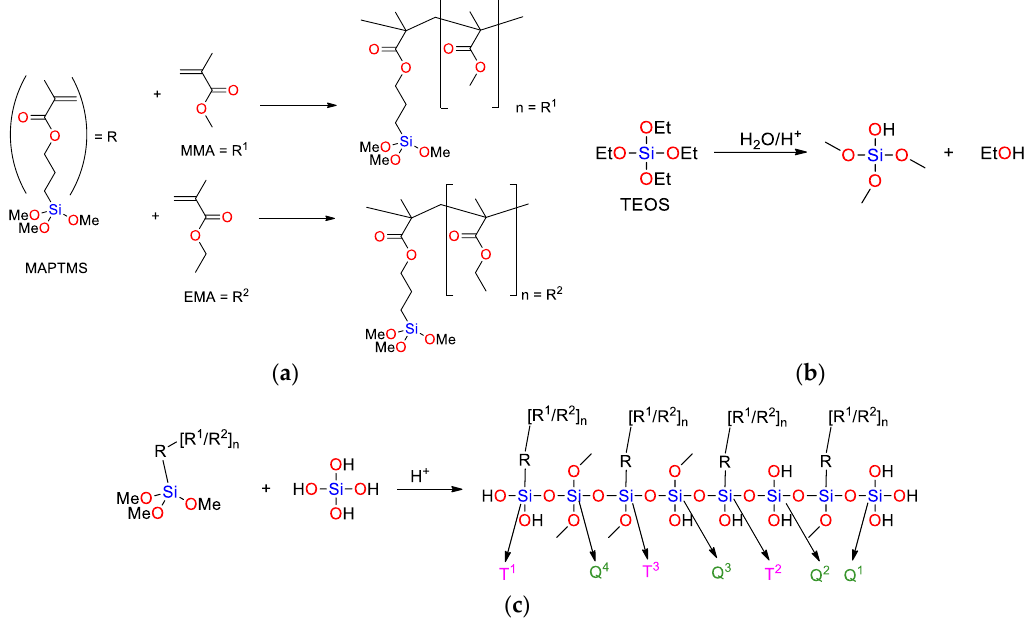
Figure 6. Postulated mechanism of polymerization, hydrolysis and polycondensation reactions in the formation of siloxane-PMMA and siloxane-PEMA sols. Different T and Q species are denoted in organoalkoxysilane (i.e., MAPTMS) with two (T 1 ), one (T 2 ) or none (T 3 ) silanol groups, and in inorganoalkoxysilane (i.e., TEOS) with three (Q 1 ), two (Q 2 ), one (Q 3 ) or no (Q 4 ) silanol groups. Methyl- and ethyl- methacrylate are denoted as MMA and EMA, respectively. ( a ) Sol 1: Polymerization; ( b ) Sol 2: Hydrolysis; ( c ) Sol 1 + Sol 2 – Network